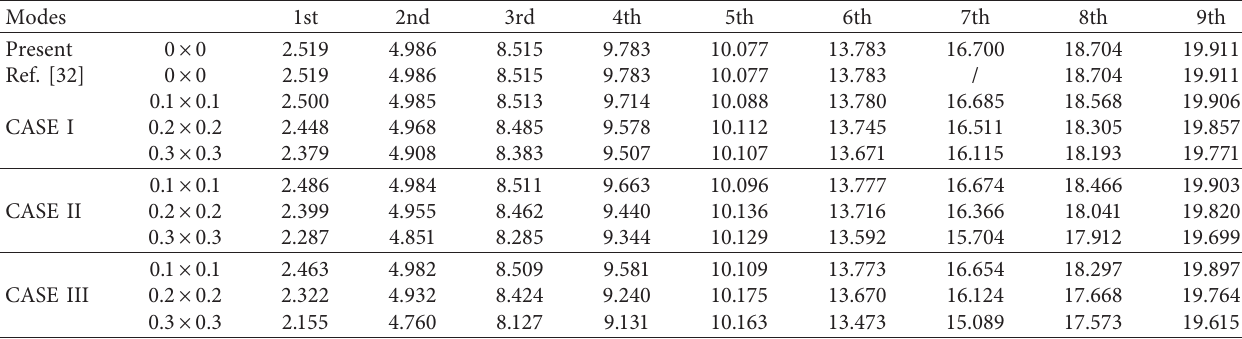
Table 4: Nondimensional frequencies of the cross-ply laminate ([0/90]s) with SSSS boundary condition, E 1/ E 2 � 10, and a � b � 10h and for different patch sizes and numbers.